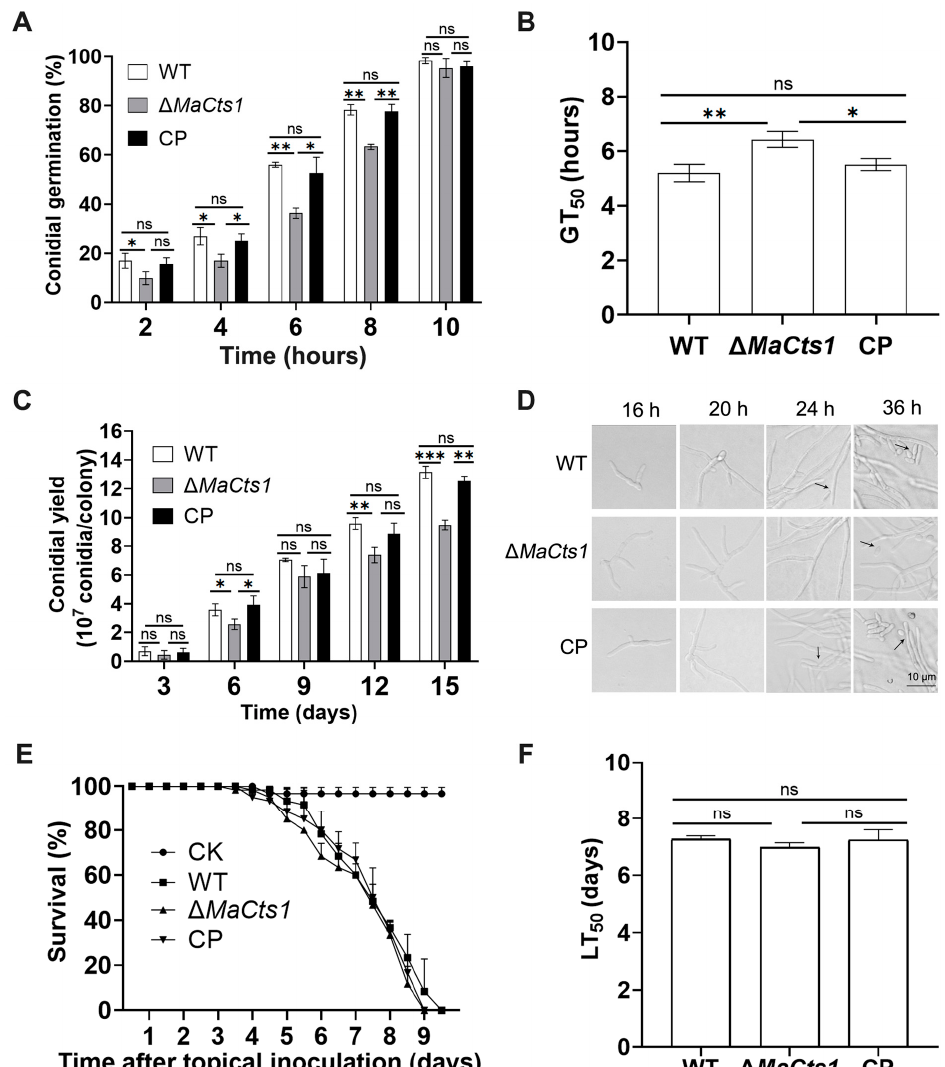
Figure 2. Inactivation of MaCts1 impaired conidial germination and influenced conidial yields, but not virulence of M. acridum . ( A ) The conidial germination (%) of the WT, ∆ MaCts1 and CP strains examined on 1/4 SDAY medium. ( B ) The median germination time (GT 50 ). ( C ) The conidial yields of the WT, ∆ MaCts1 and CP strains assessed on 1/4 SDAY medium. ( D ) The initial stage of conidiation of the WT, ∆ MaCts1 and CP strains on 1/4 SDAY medium. Arrows indicate conidia on the conidiophores. ( E ) Locust survival (%) after topical inoculation of conidia from the different strains. ( F ) The median lethal times (LT 50 s). Error bars indicate the standard deviation from triplicate experiments. One, two and three asterisks indicate a significant difference at p < 0.05, p < 0.01, p < 0.001, respectively. “ns” indicates no significant difference.